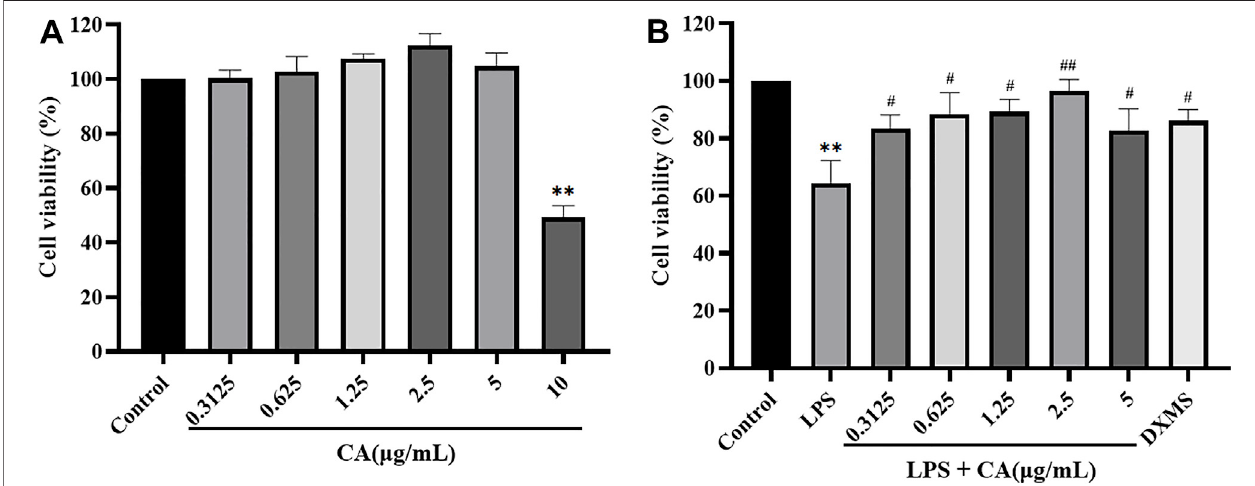
FIGURE 8 | The toxicity efferets after CA treatment in RAW264.7 cells. The effects of CA on RAW264.7 cells cytotoxicity (A) ; The effects of CA on LPS-induced RAW264.7 cells proliferation ability (B) . Cells were pretreated with or without various concentrations of CA for 2 h, and then co-incubated with or without LPS (1 μ g/ ml) for 24 h. Cell viability was assessed by MTT. ** p < 0.01 vs . control group; # p < 0.05, ## p < 0.01 vs . LPS